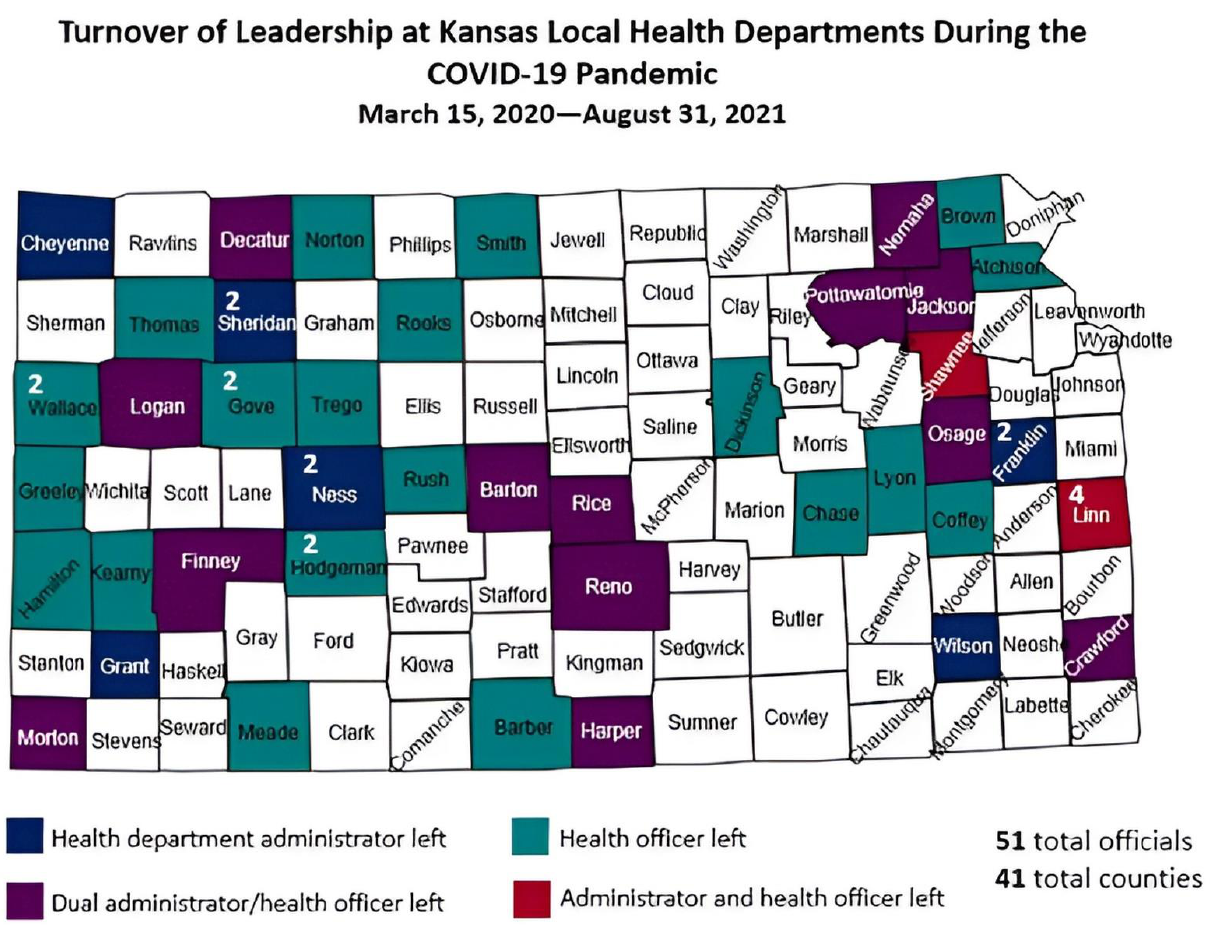
Figure 1. Turnover of Leadership of Kansas Local Public Health Officials during the COVID-19 Pandemic—15 March 2020–31 August 2021. Table 1. Participant Demographics and Professional Characteristics (n =